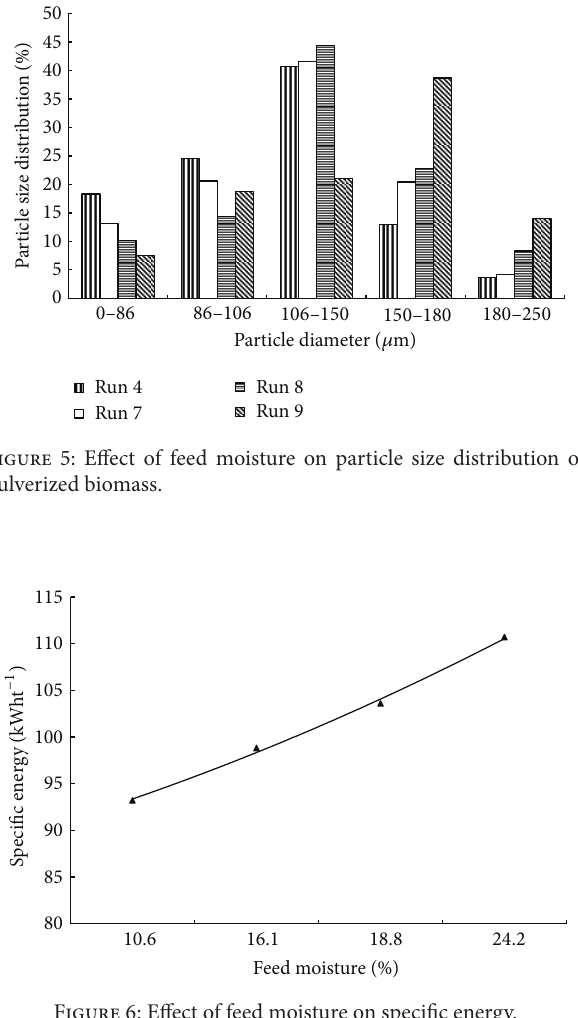
Figure 6: Effect of feed moisture on specific